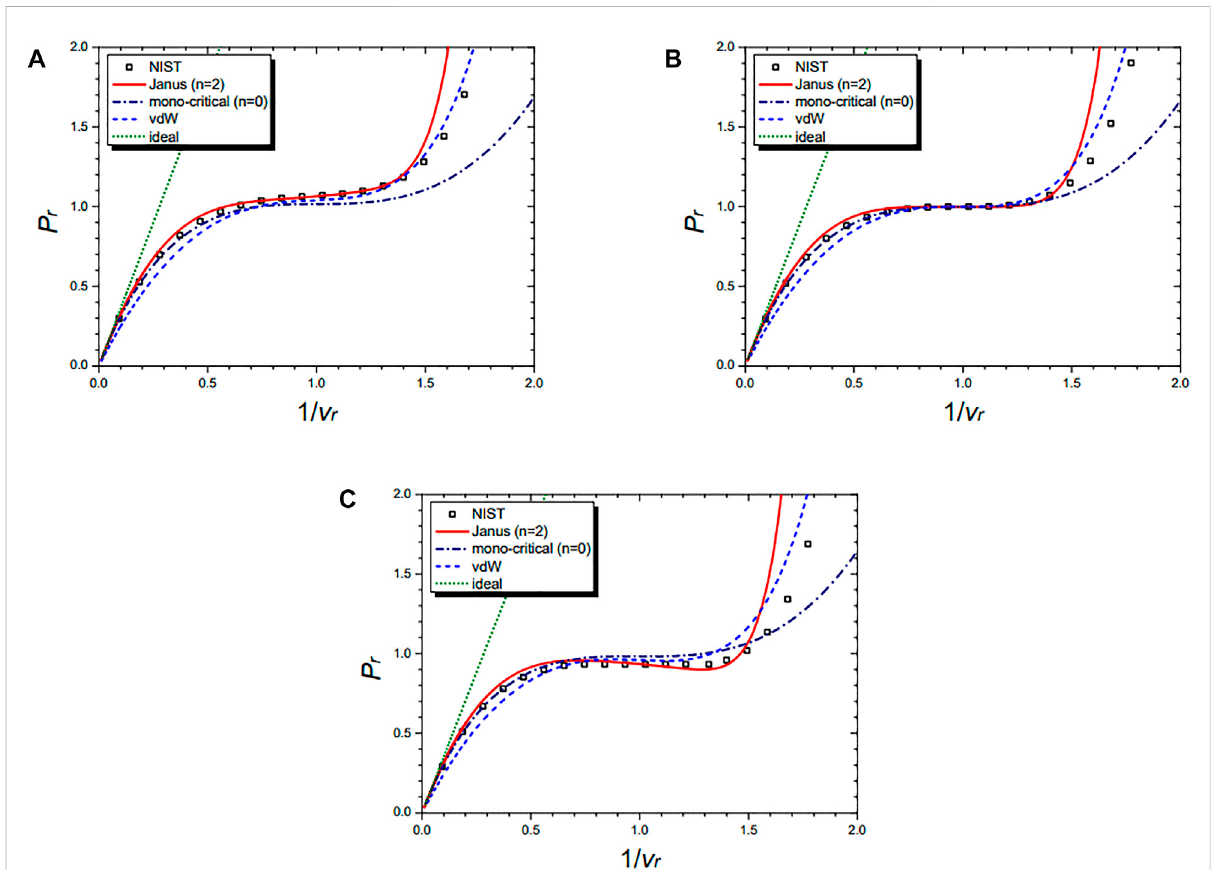
FIGURE 5 Isothermal curves of cyclopentane (C 5 H 10 ) at T r = 1.01 (A) , T r = 1.00 (B) , and T r = 0.99 (C) , respectively. Boxes are from the NIST data. The red solidlineisdrawnfromthe n =2JanusvanderWaalsEq.23andisbetter fi ttedthanthe n =0mono-criticalEq.21,theoriginalvanderWaalsEq.1,or the classical ideal gas law